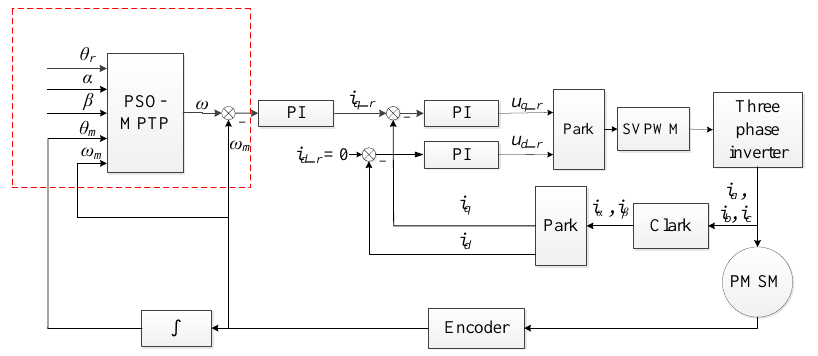
Figure 7. Three-phase closed-loop control diagram of the motor.